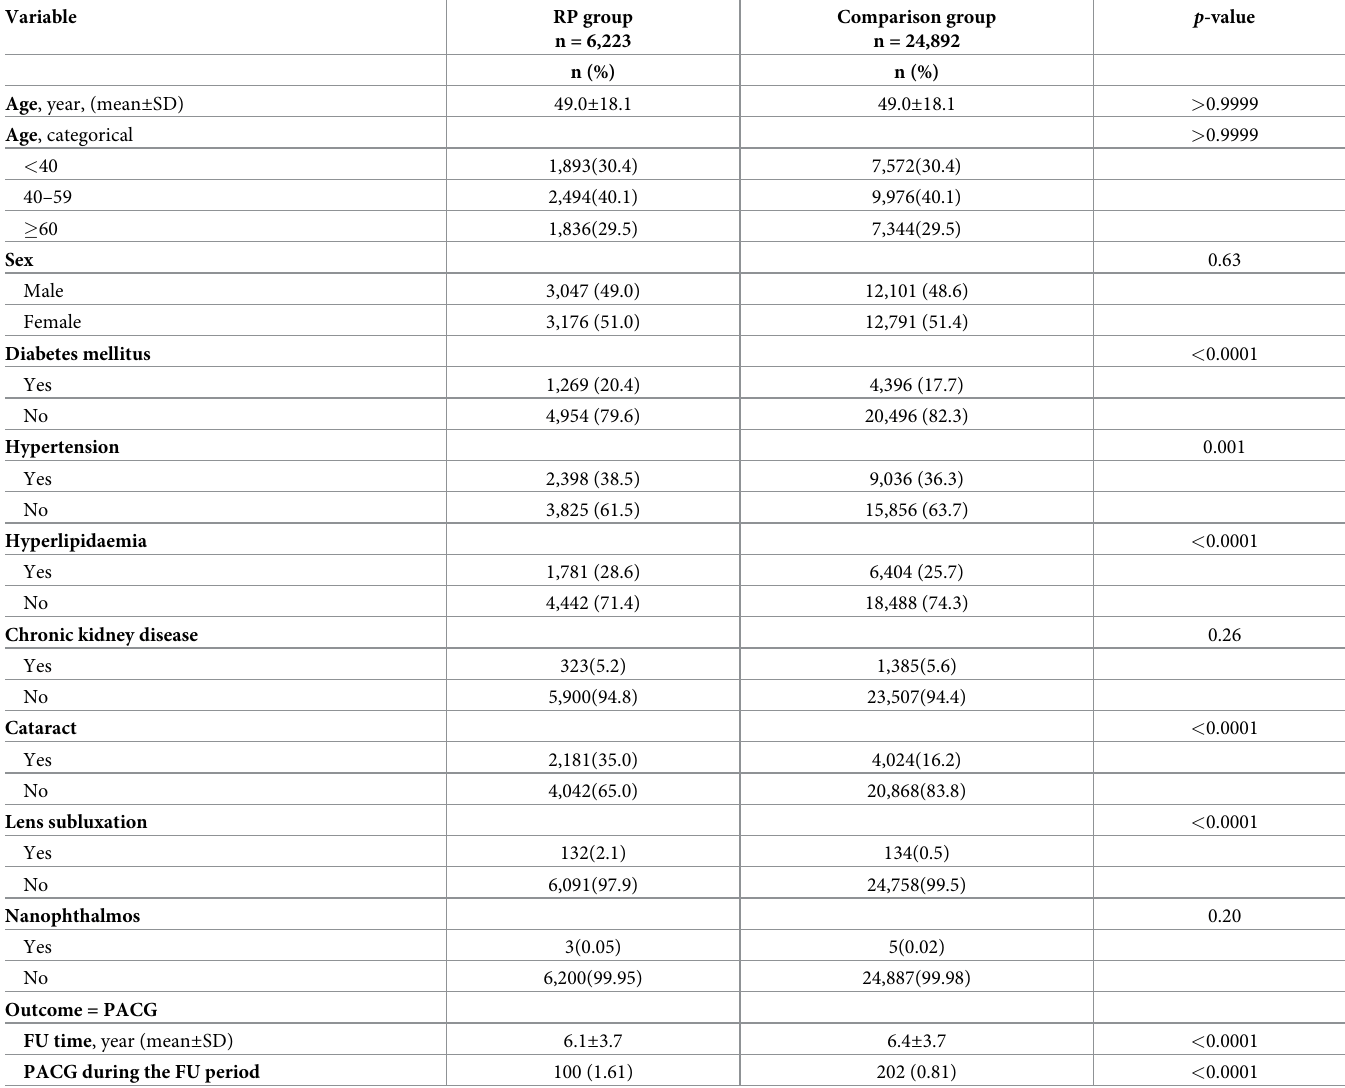
Table 1. Characteristics of the study